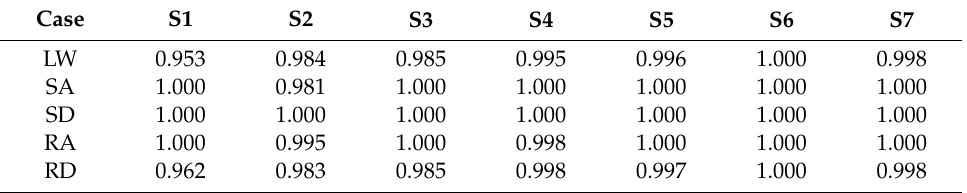
Table 7. Classification performance (F1-score) for each subject.